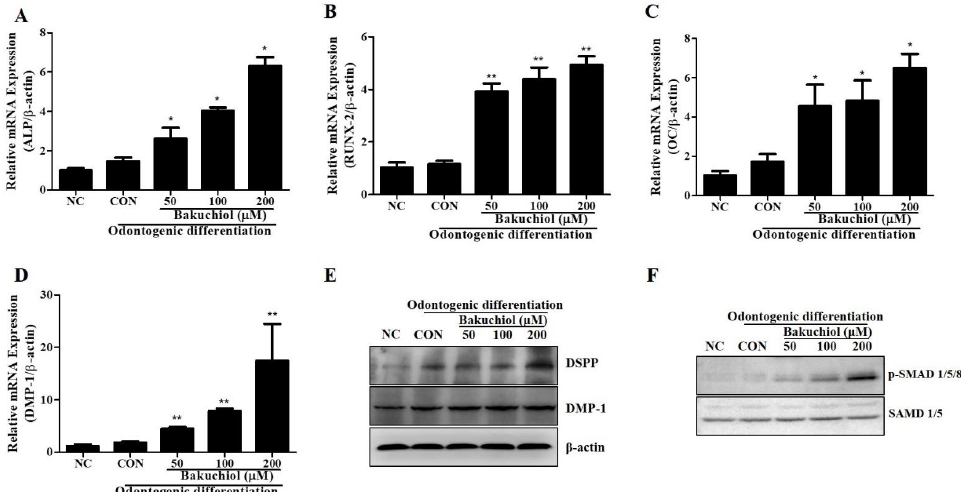
Figure 4. Real-time PCR analysis during odontogenic differentiation in hDPSCs. ( A – D ) Odontogenic differentiation marker gene expression was evaluated using real-time PCR. Expression of APL, RUNX-2, OC, and DMP-1 in hDPSCs treated with 50, 100 and 200 µ M of bakuchiol. ( E ) Western blot analysis for the expression of odontogenic differentiation protein markers DMP-1 and DSPP. ( F ) Western blot analysis to determine the effect of bakuchiol on SMAD 1/5/8 phosphorylation cell signaling pathway during odontogenic differentiation. All data are presented as the mean ± SEM (n = 3). * p < 0.05, ** p < 0.02 SEM, standard error of mean; NC, negative control; CON, positive control; hDPSCs, human dental pulp stem cells; PCR, polymerase chain reaction.